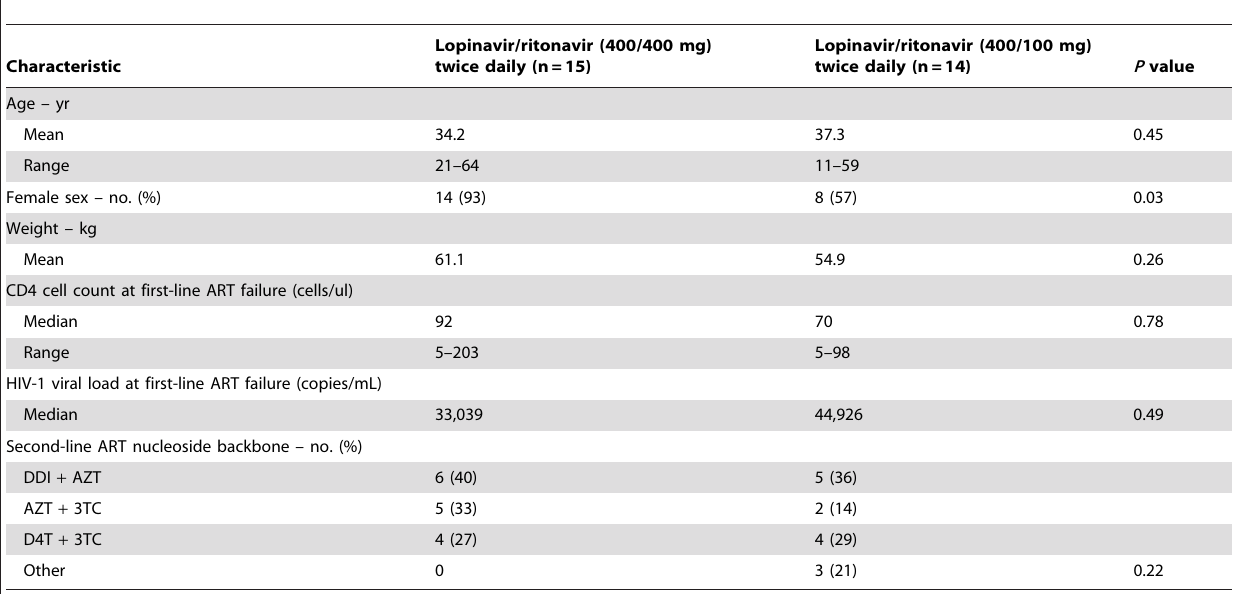
Table 1. Baseline characteristics of patients at initiation of lopinavir/ritonavir-based second line ART, according to treatment group.